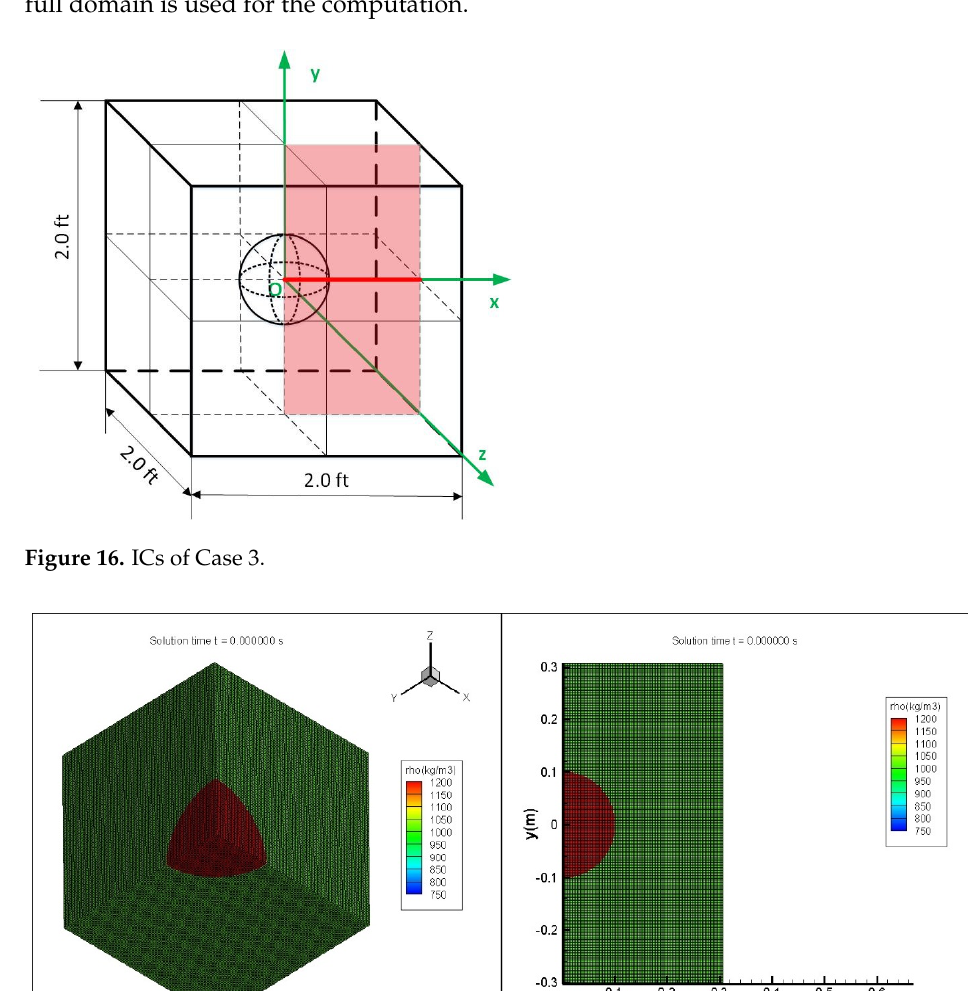
Figure 16. ICs of Case 3.